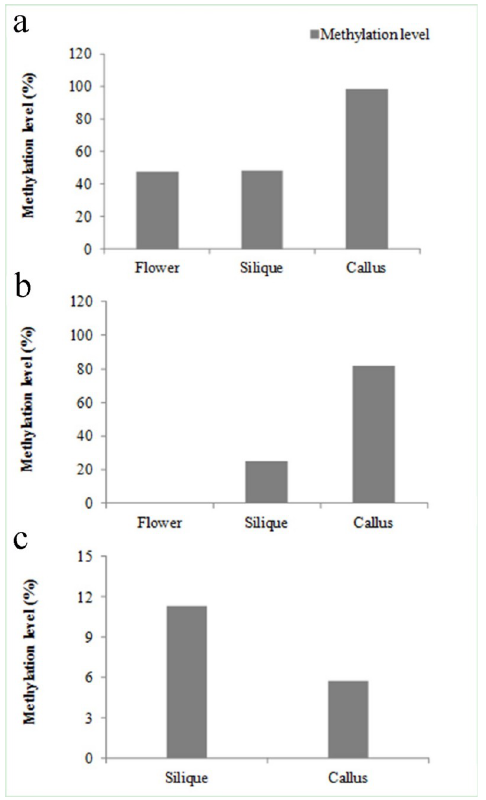
Fig 8. Comparisons of DNA methylation level of positively selected genes with tissue specificity in six B . rapa tissues (roots, stems, leaves, flowers, siliques and callus) at CG (a), CHG (b) and CHH (c) contexts.